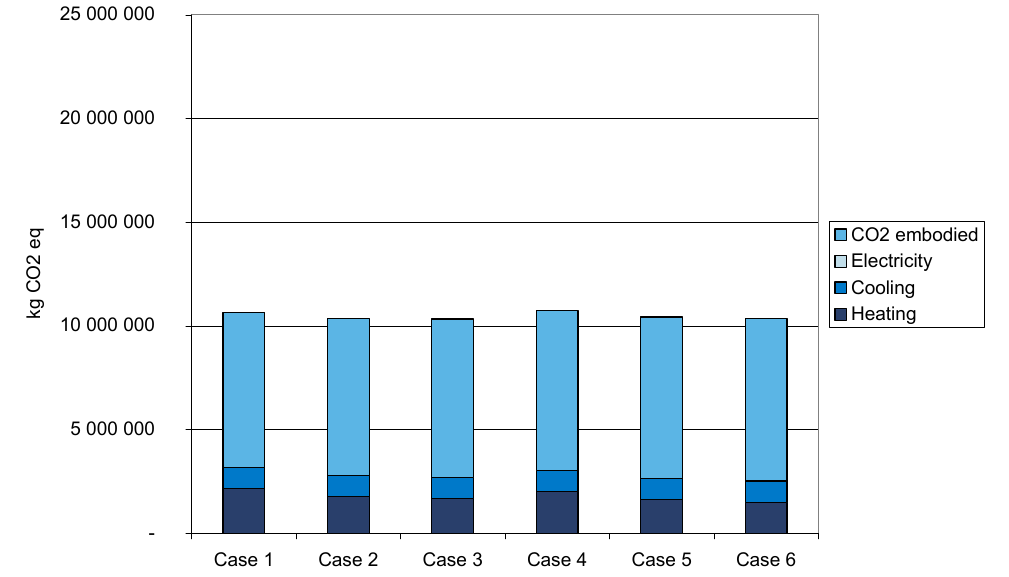
Figure 4. The share of each energy consumption and embodied CO cases when district heating, cooling from bio-fuels is used and electricity is from renewable energy